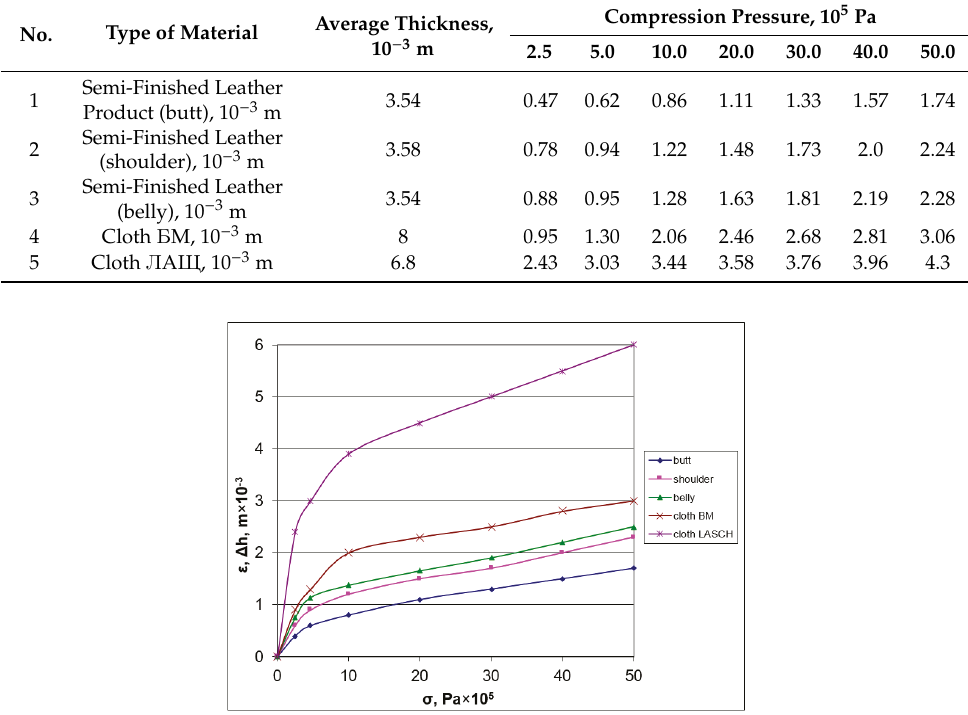
Table 2. Average strain in the materials from the force of compression pressure.